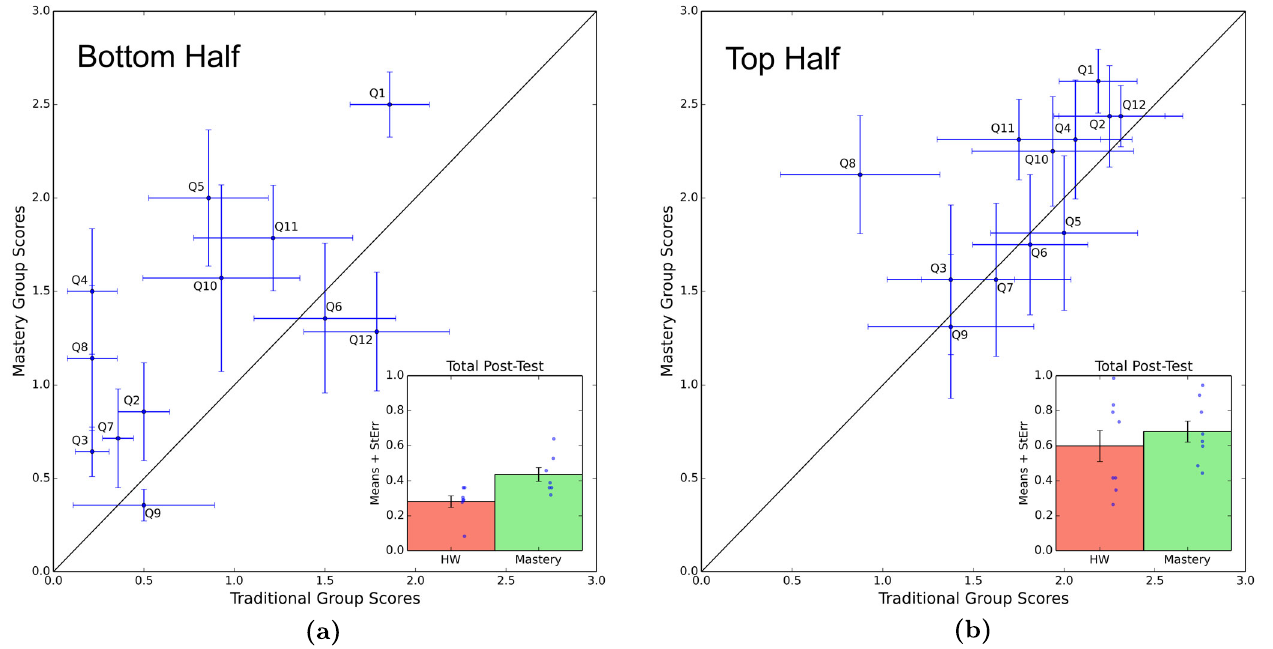
FIG. 3. Performance of students in the first clinical trial with students in the top and bottom half of each homework condition group analyzed separately. This median split was performed using the students ’ final semester course scores. Dots on the inset graphs show individual student post-test totals. (a) Performance of students in the bottom half of each homework condition group as measured by their final semester course scores. The difference in post-test total scores is significant with p < 0 . 05 on a one-tail t -test. (b) Performance of students in the top half of each homework condition group as measured by their final semester course scores. The difference in posttest total scores is not